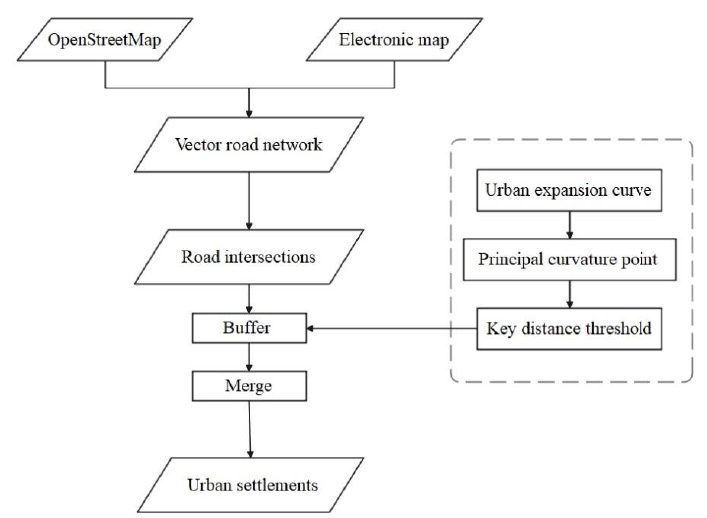
Figure 3. Process of the extraction of urban settlements.